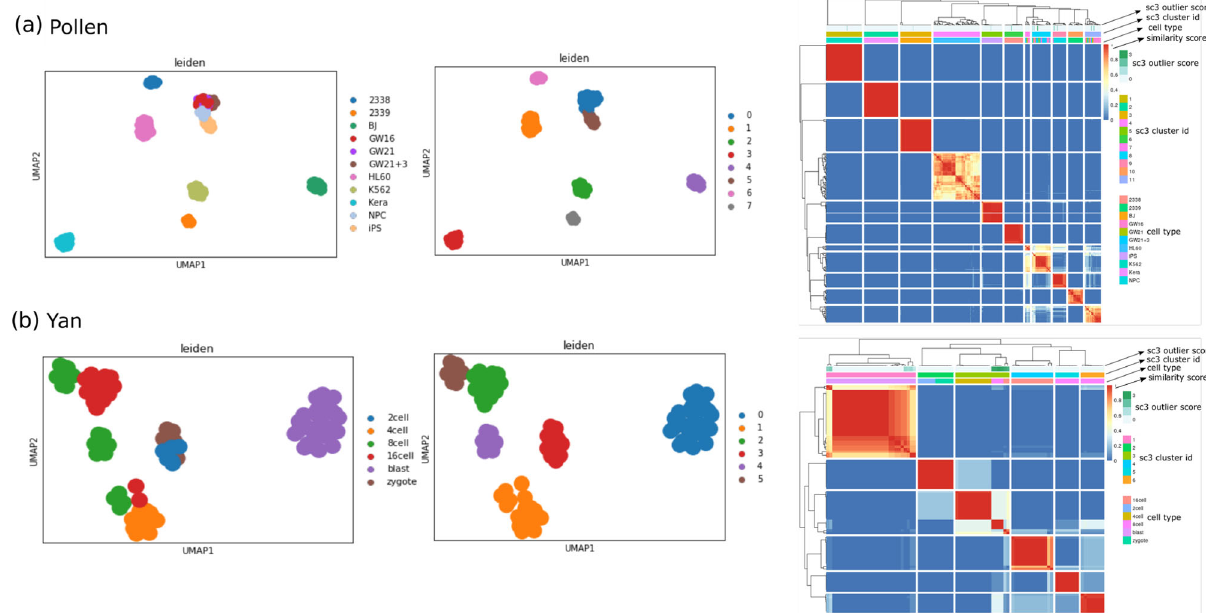
Fig. 4 Clustering results of Pollen and Yan datasets. a Two-dimensional UMAP visualization of clustering results (original and predicted labels). b Consensus clustering plots of obtained